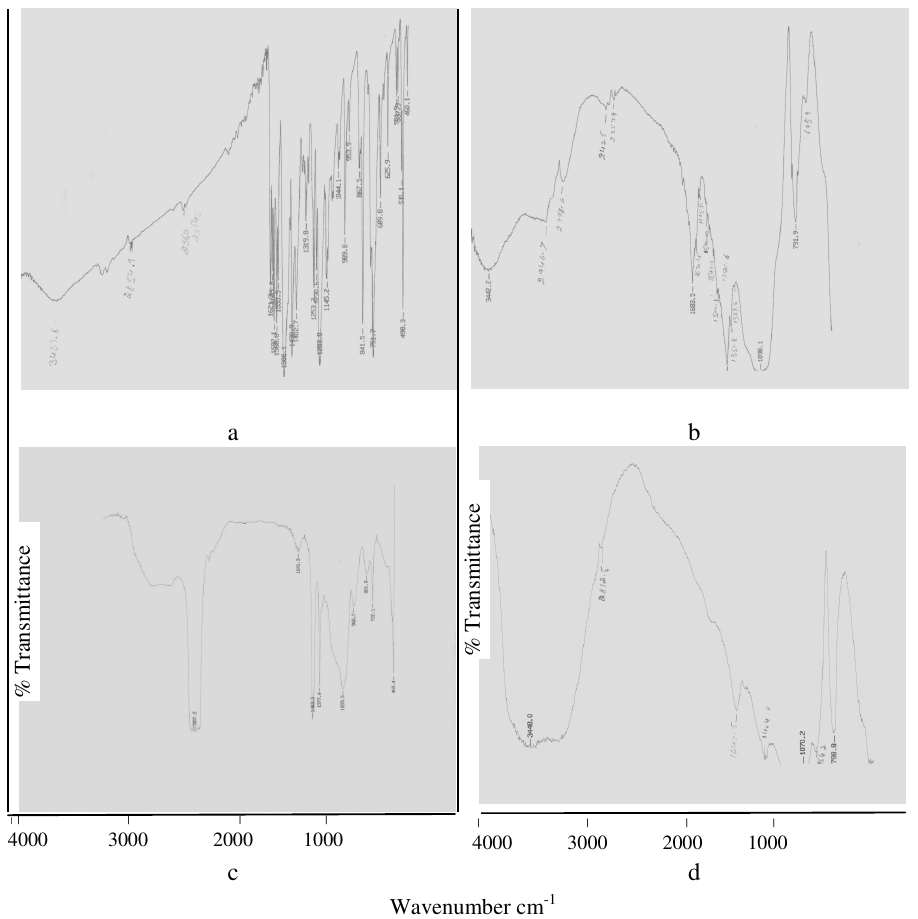
Figure 4. FTIR spectra (a) PAN (b) nanometer SiO (d) nanometer SiO